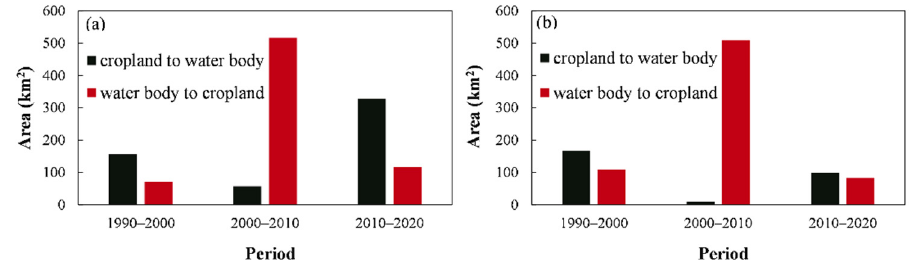
Figure 15. The area transition between cropland and water body in Poyang Lake and Dongting Lake from 1990 to 2020. ( a , b ) indicate Poyang Lake and Dongting Lake, respectively.